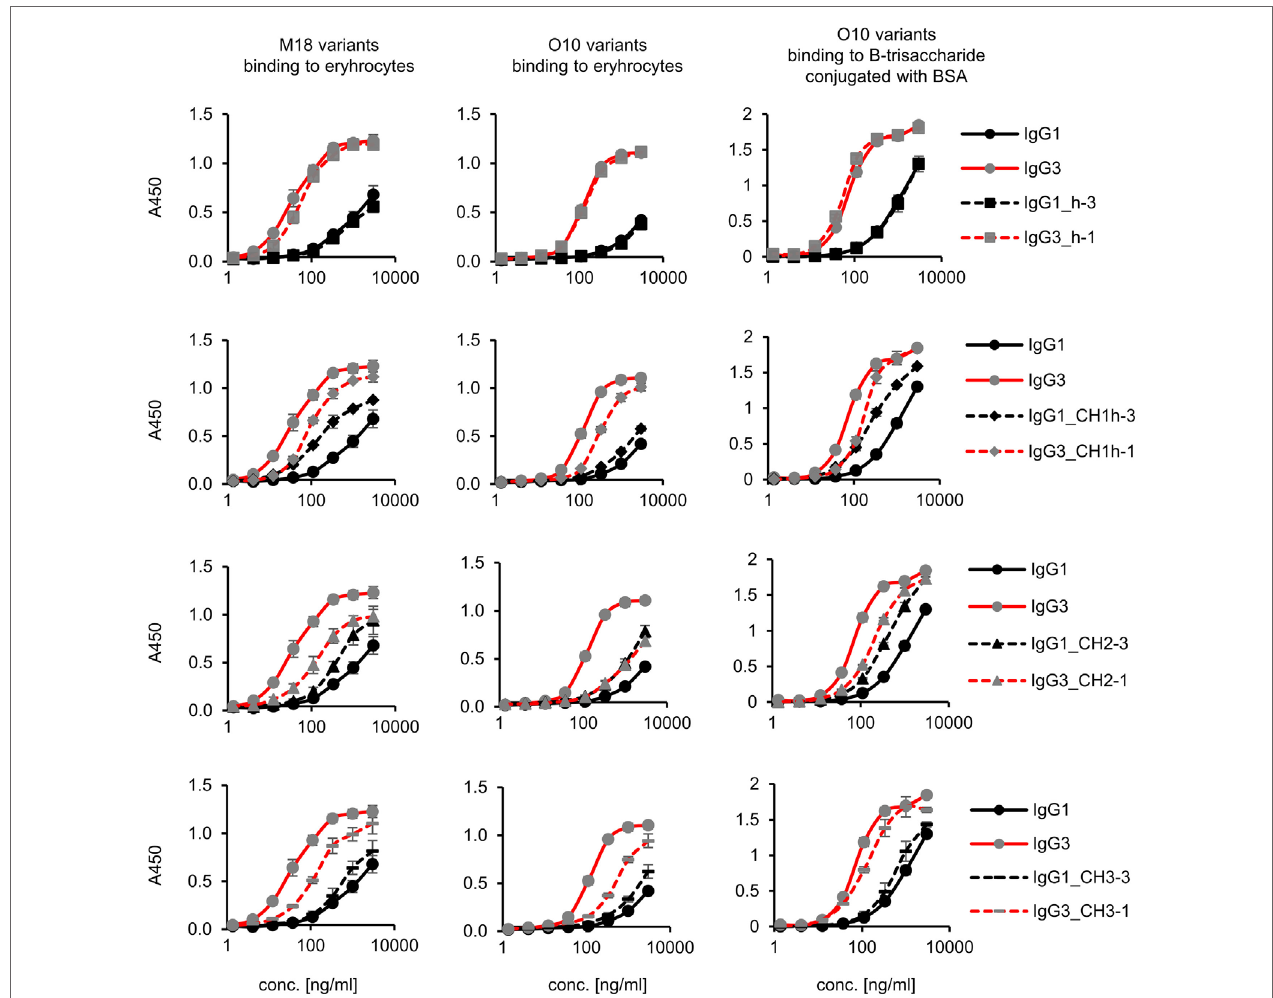
FigUre 3 | Antigen binding by the domain muteins. M18 and O10 antibodies are specific to B-antigen present on human erythrocytes. B-antigen is a pentasaccharide O-glycan. O10 antibody, but not M18, binds terminal fragment of the antigen, called B-trisaccharide. Antigen–antibody interaction was analyzed using ELISA on immobilized erythrocytes. In the case of O10, plates coated with BSA conjugated with the synthetic B-trisaccharide were also used. The plots present mean values from two independent experiments performed in duplicates. Results obtained for IgG1 and IgG3, the parental molecules, are presented on each plot to allow convenient